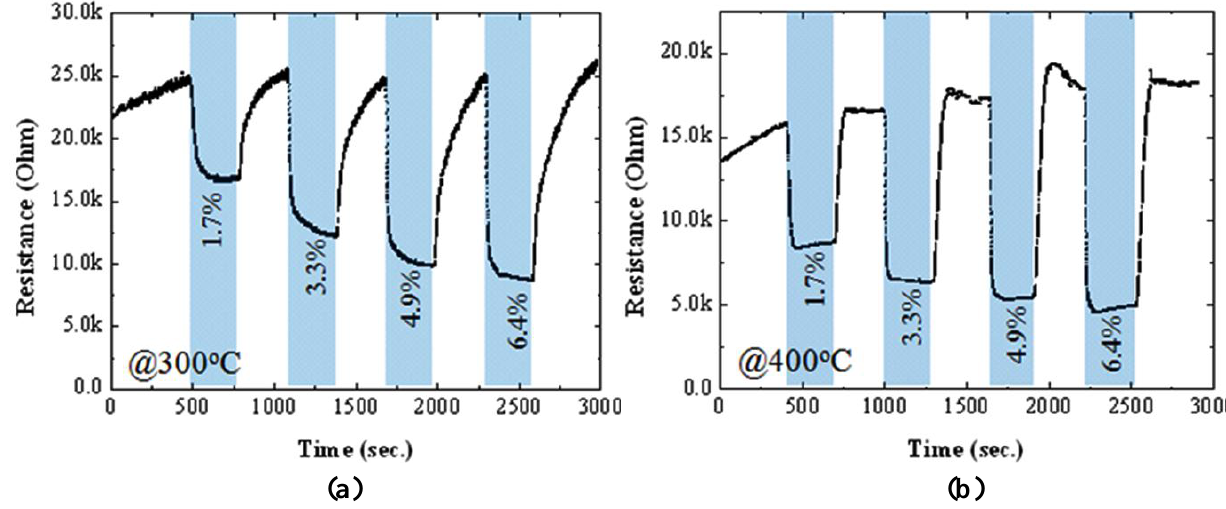
and LPG (1.7~6.4 vol.%) at operating temperatures 2